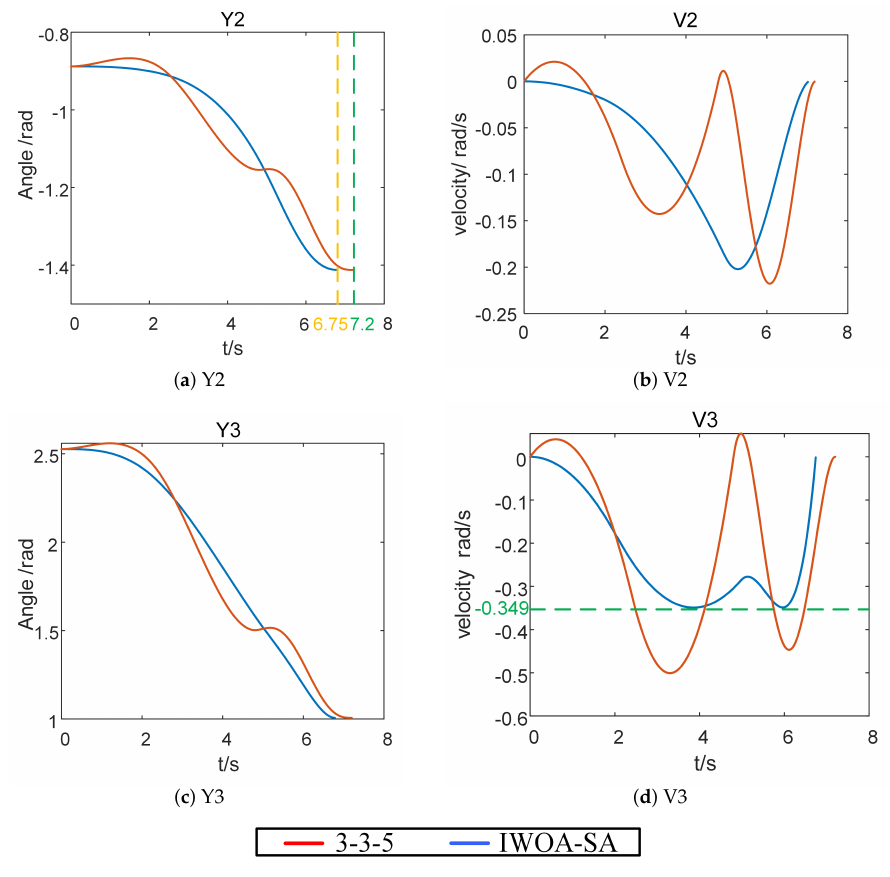
Figure 6. Running curve of each joint after using the optimization algorithm. ( a ) Y2, ( b ) V2, ( c ) Y3, ( d ) V3.